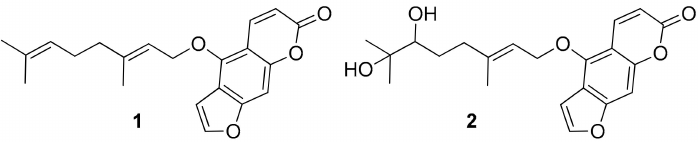
Figure 1. Chemical structures of bergamottin ( 1 ) and 6 (cid:48) ,7 (cid:48) -dihydroxybergamottin ( 2